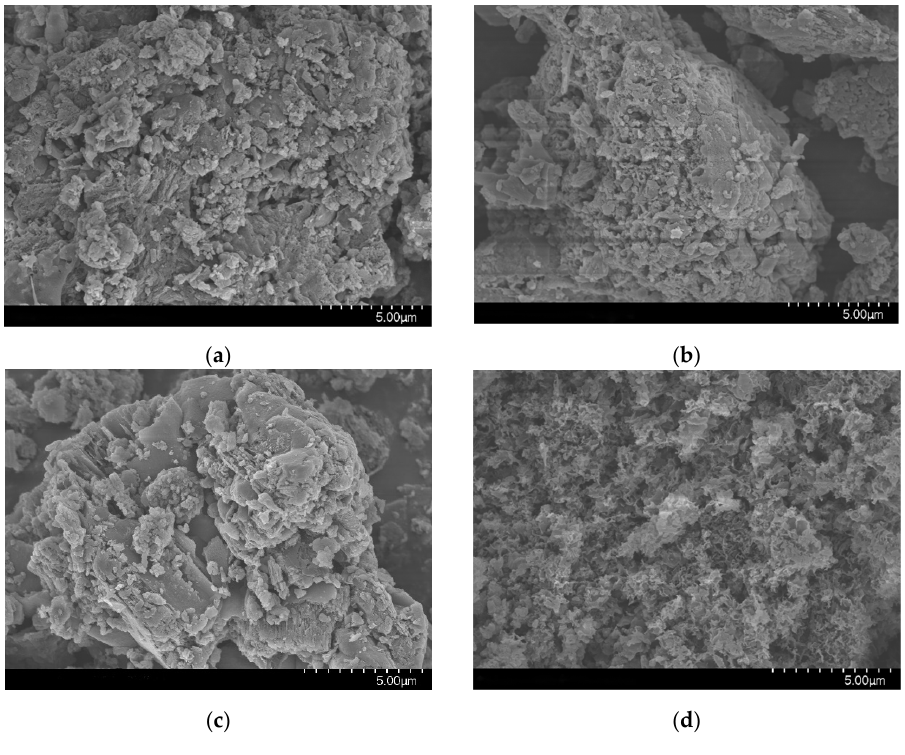
Figure 2. SEM of g-C 3 N 4 : ( a ) D-CN, ( b ) M-CN, ( c ) T-CN, and ( d ) U-CN.